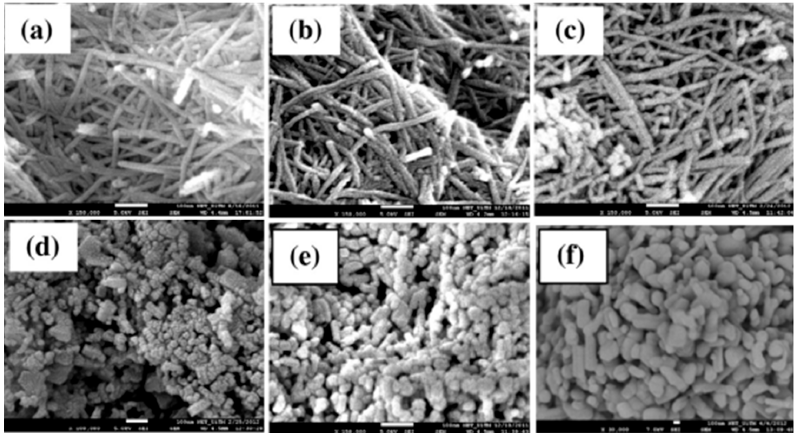
Figure 2. FESEM images of the as-prepared nanowires ( a ) and nanowires annealed at ( b ) 400 °C, ( c ) 500 °C, ( d ) 600 °C, ( e ) 700 °C and ( f ) 900 °C. Reprinted with permission from Ref. [12] Elsevier Copyright 2013.